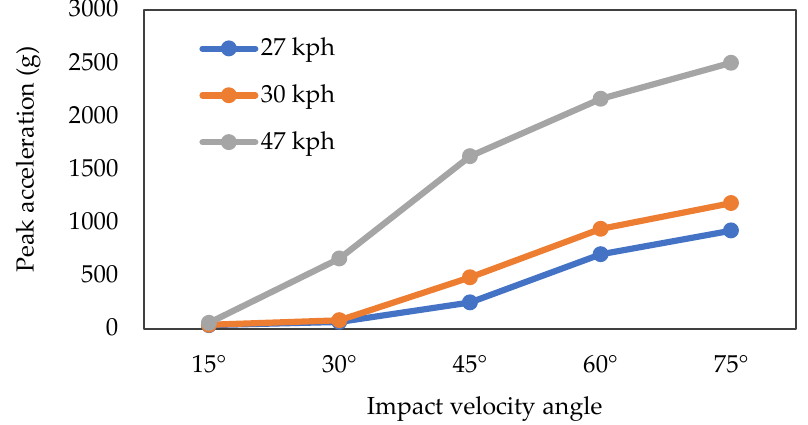
Figure 10. Peak acceleration for each condition for the sliding case.